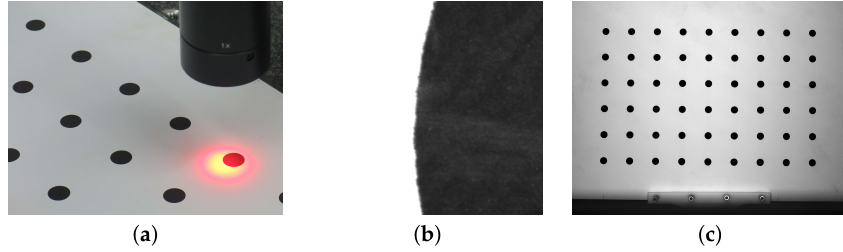
Figure 2. The calibration artifact. ( a ) The validation process of the calibration artifact. ( b ) The RAW image from the Carl Zeiss Viscan Optical Header representing the magnitude of one of the markers, where the size of the measurement field is 4.8 × 6 mm and resolution is 6 µ m. ( c ) The calibration image captured by the tested camera, 6 × 9 circle markers with a diameter of 8 mm and nominal distances along the X and Y axes of 30